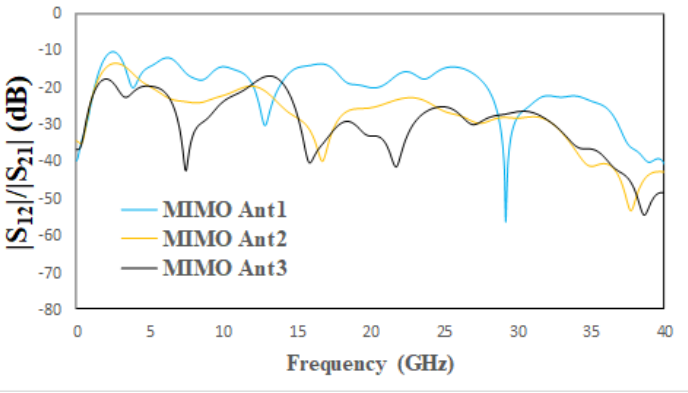
Figure 4. | S | Parameters of design evaluation steps of decoupling stub. Parameters of design evaluation steps of decoupling stub. Figure 4. | 𝑆𝑆 | Parameters of design evaluation steps of decoupling stub. Figure 4. | 𝑆𝑆 |